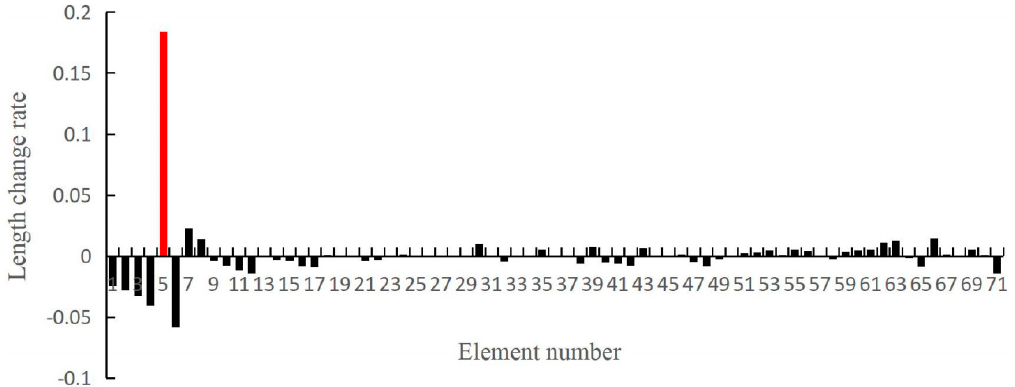
Figure 4. Rate of change of element length obtained from the static data (element 5 had damage with no noise).